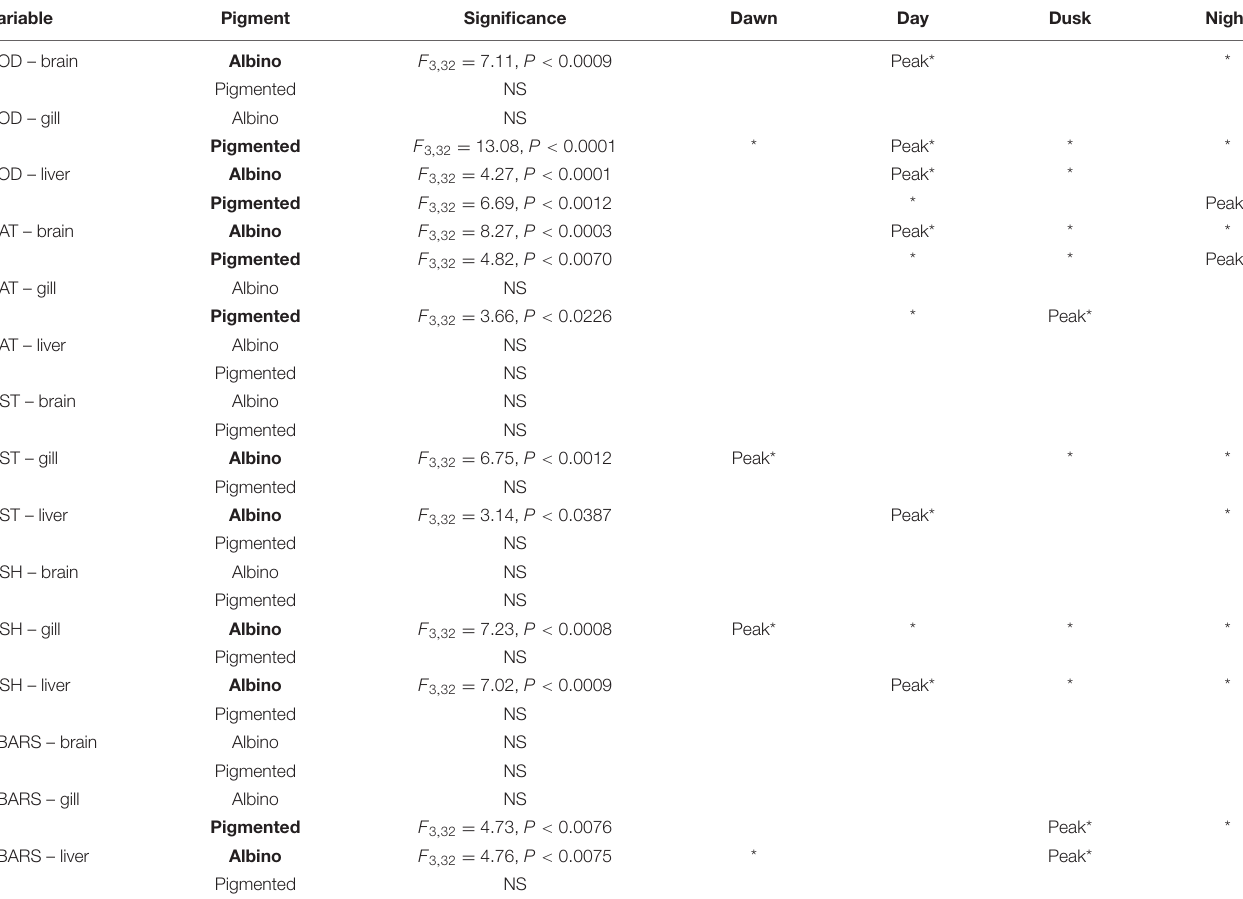
TABLE 2 | Diel rhythms of antioxidants and oxidative stress indicators detected in fish tissues (brain, gill, and liver).